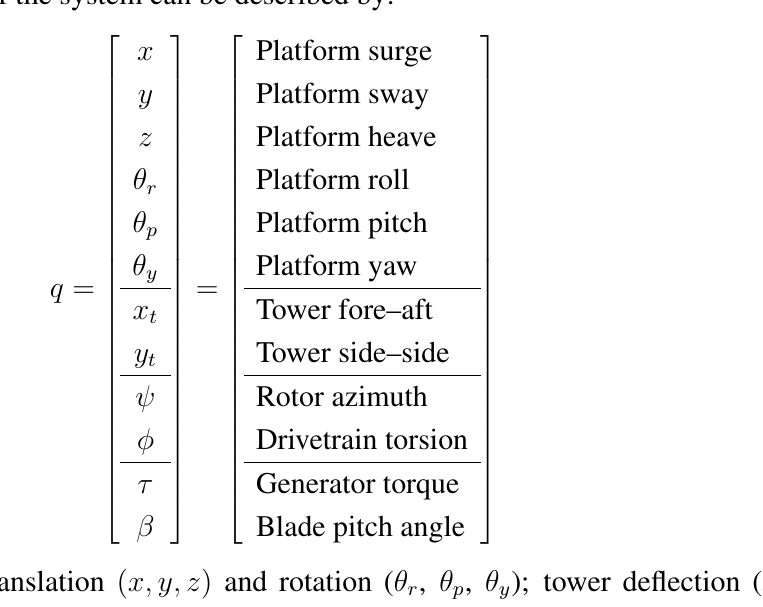
Figure 2. Floating wind turbine comprising a wind turbine mounted on a floating spar buoy platform (note: the mooring system is not shown). Drivetrain torsion, torque actuator and pitch actuator are not described. COM is the total center of mass and COB is the total center of buoyancy.